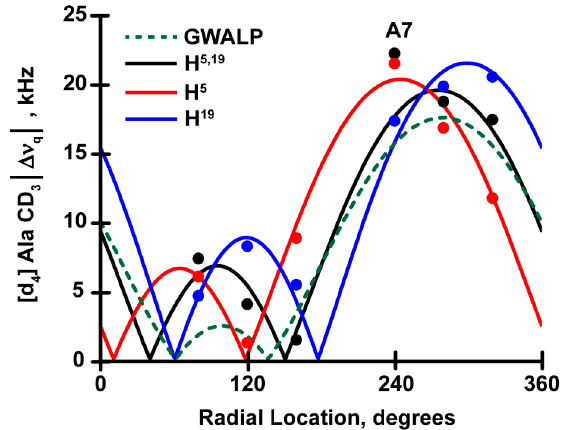
Figure 5. Quadrupolar wave analysis for oriented H 5 GWALP (red), H 19 GWALP (blue) and GH 5,19 ALP23 (black) peptides in DOPC lipid bilayers. The analysis for the host peptide GW 5,19 ALP23 shown as a dotted green wave.